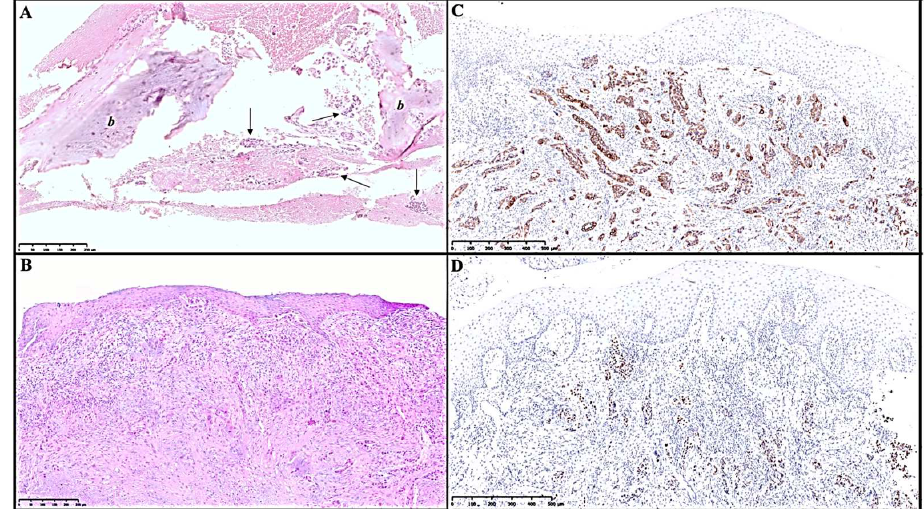
Figure 6. ( A ) Histological image of an intraosseous metastasis from lung adenocarcinoma, showing bone fragments ( b ) intermingled with groups of neoplastic cells (arrows) [100×, H.E.]; ( B ) Oral submucosal infiltration of malignant poorly formed glands [100×, H.E.]; ( C ) Immunohistochemical staining showing CK7 positivity in neoplastic glands [50×, H.E.]; ( D ) Immunohistochemistry reveals positivity for TTF-1 in neoplastic cells, suggesting lung origin [50×, H.E.].